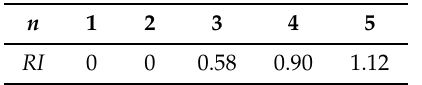
Table 3. Value of a random consistency index.